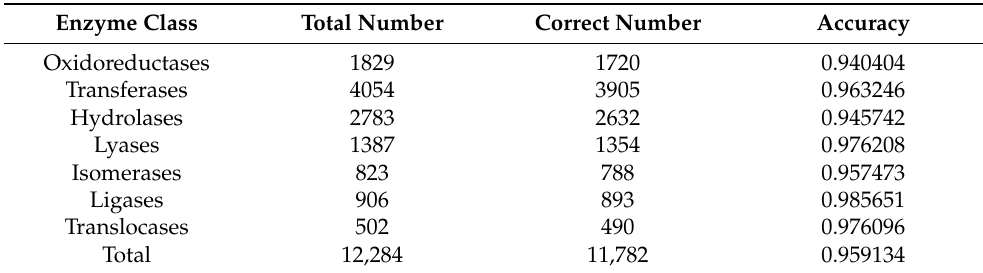
Table 3. Classification results of the E. coli